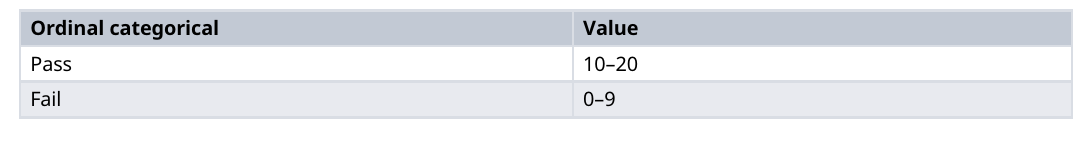
Table 4. Binary levels classification.